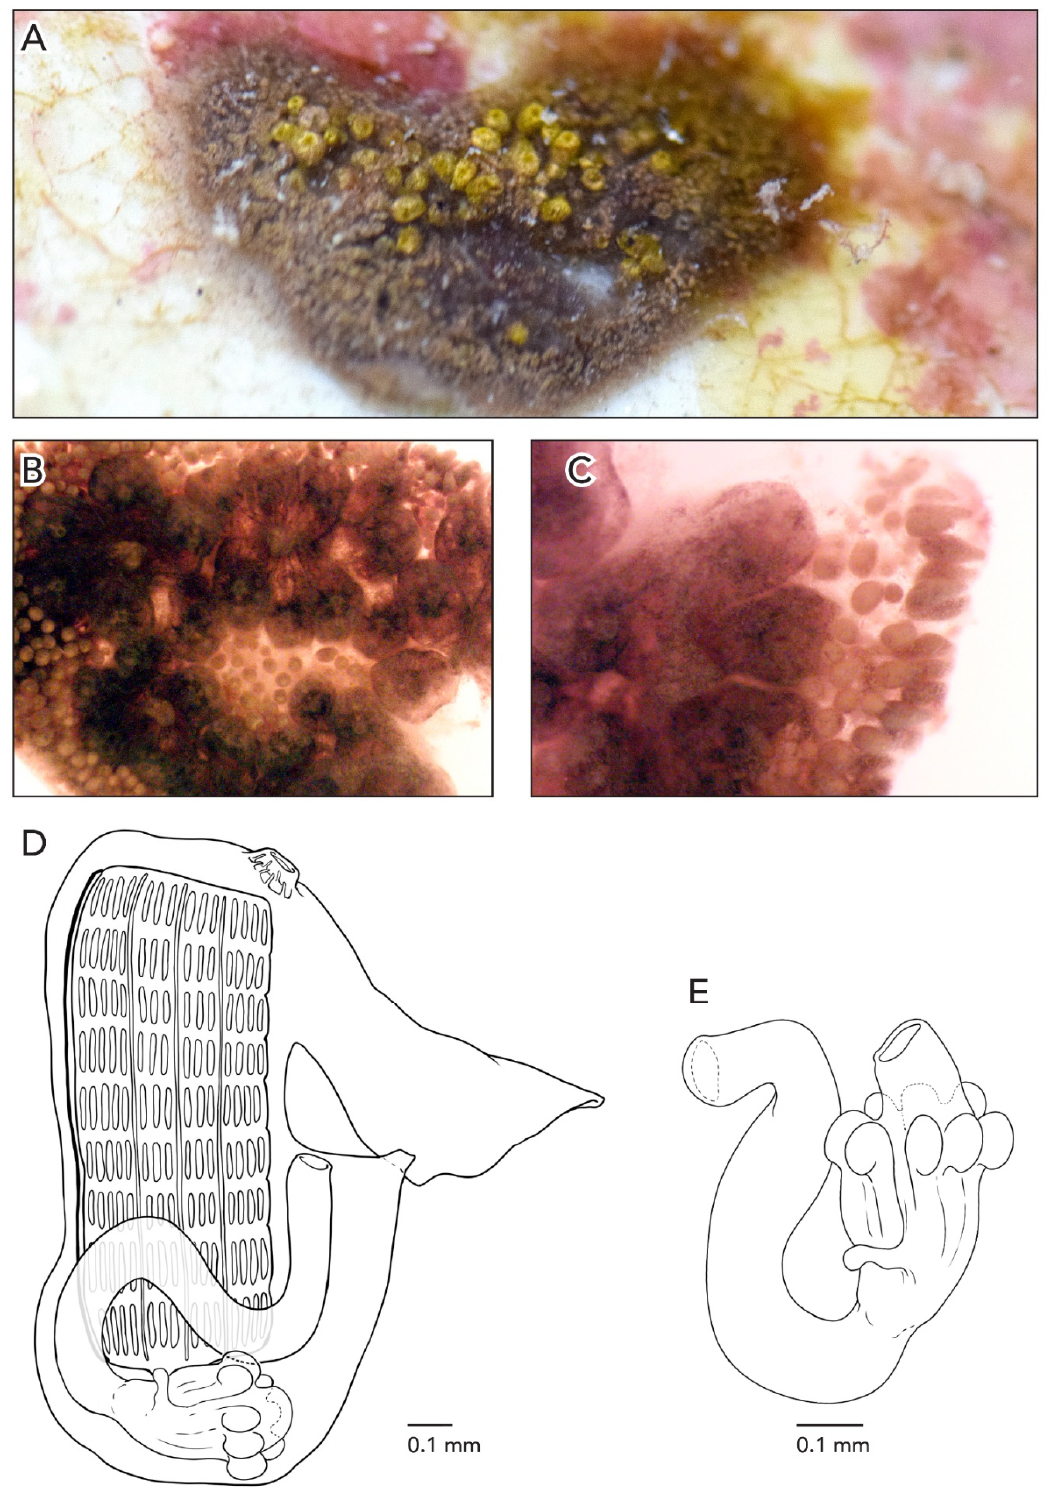
Figure 12. Botrylloides ampullarius sp. nov.